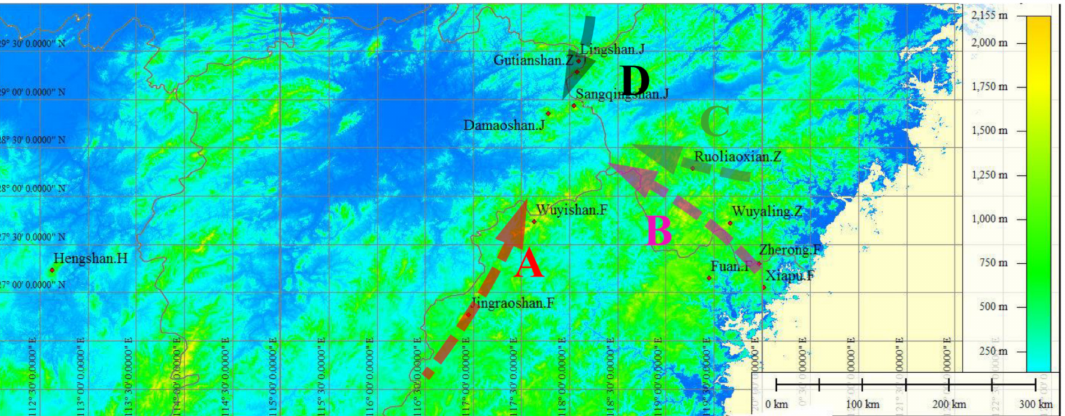
Figure 1. Geographic distribution of the 12 sampled populations of C. chekiangoleosa . The dots in the figure are the collection points of each test sample. A —Wuyi mountain range population; B —Donggong mountain range population; C —Xianxia mountain range population; D —Huaiyu mountain range